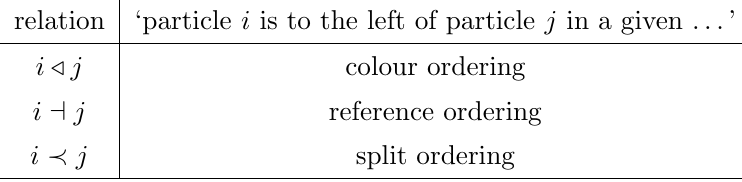
Table 1 . Notation for colour-ordering, reference-ordering and split-ordering